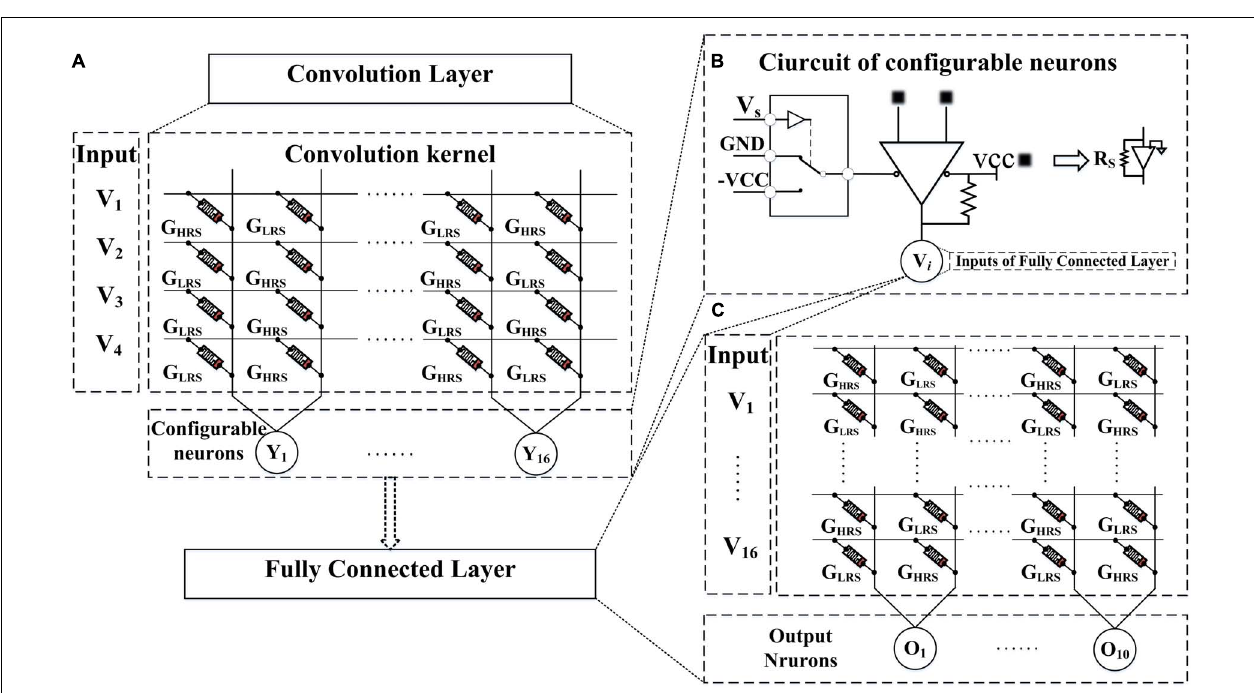
FIGURE 6 | The example depicts the hardware implementation of the CFB-CNN architecture, (A) module of convolution layer, (B) detailed circuit of configurable neurons, (C) module of fully connected